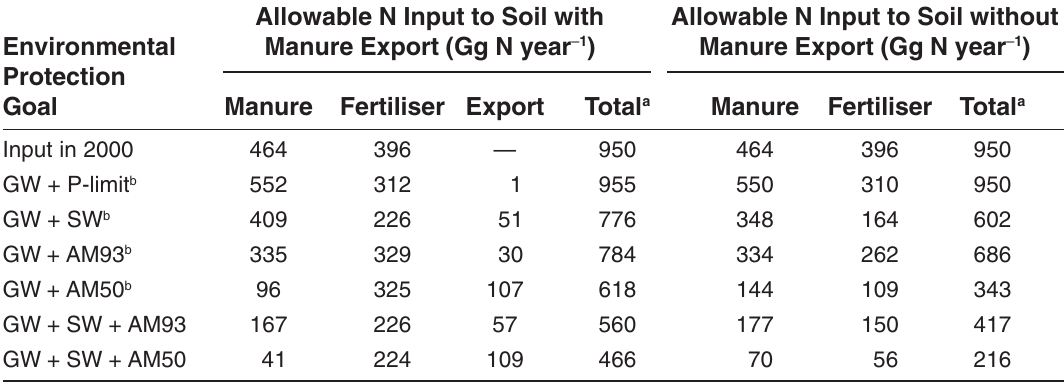
Acceptable Soil N Inputs Related to Different Criteria for Groundwater, Surface Water, and Optimised NH Ceilings, Including and Excluding Export of Manure 3 Allowable N Input to Soil with Allowable N Input to Soil